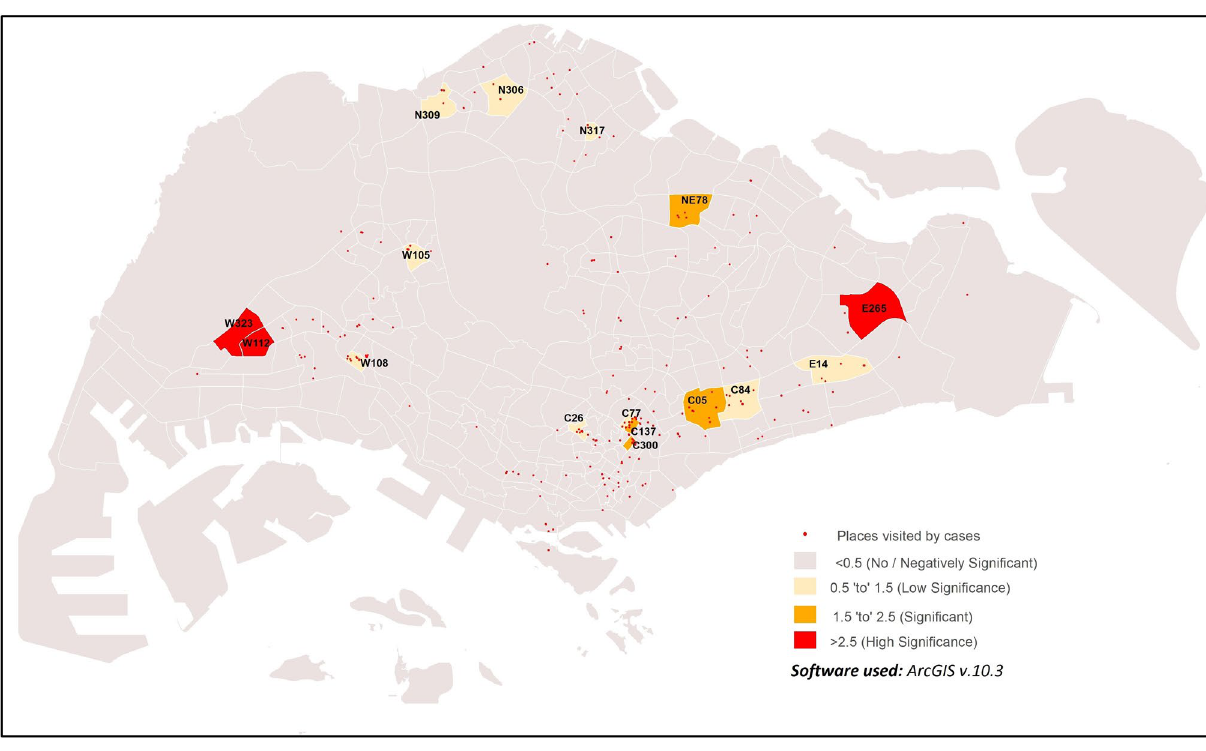
Figure 4. GWR of population density and places visited by COVID-19 cases from 19th May 2020 to 31st July